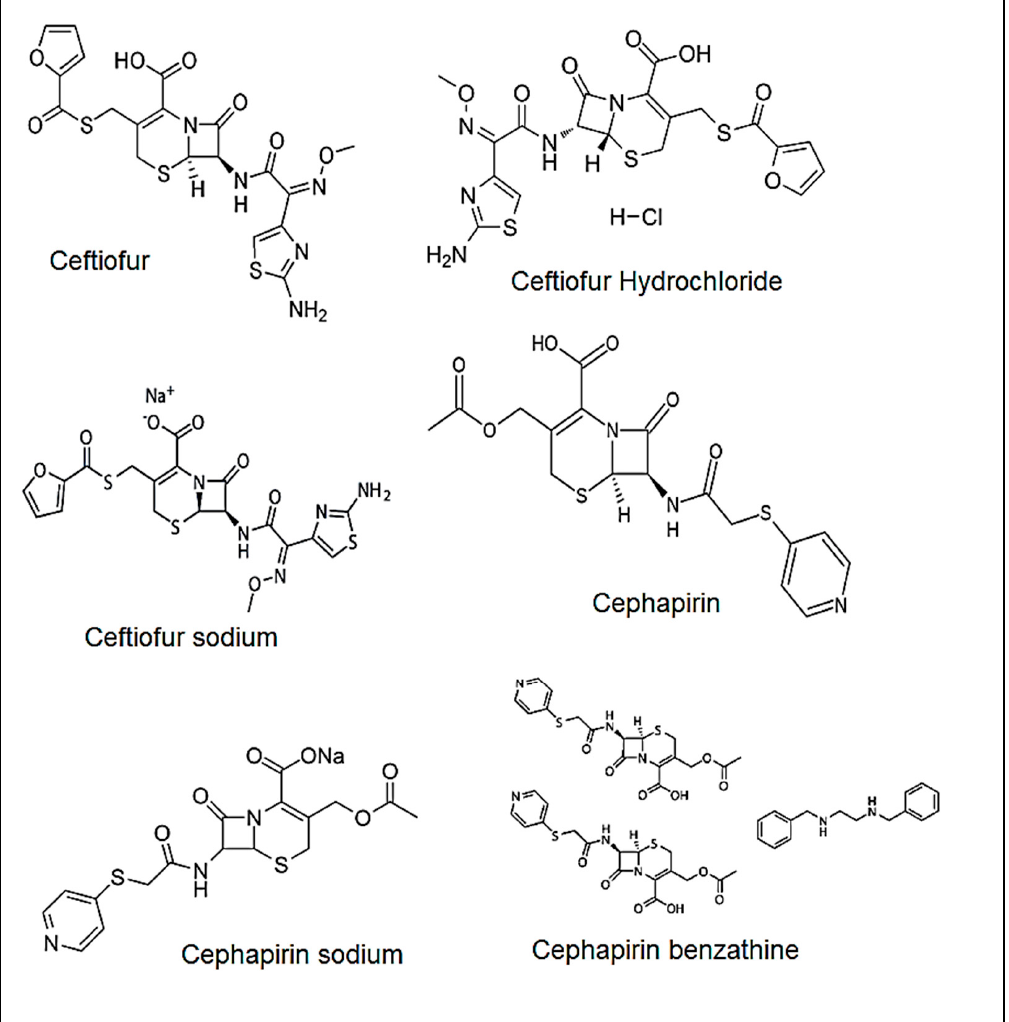
Figure 1. Structures of Ceftiofur, Ceftiofur Hydrochloride, Ceftiofur Sodium, Cephapirin, Cephapirin sodium, and Cephapirin Benzathine.